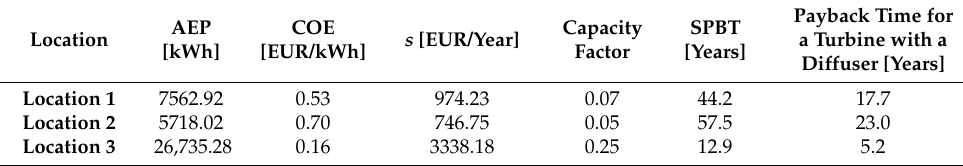
Table 5. Economic comparison of selected locations–simulation